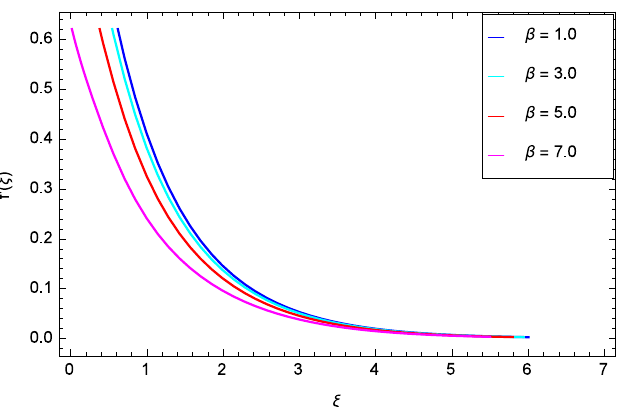
Figure 3. Impact of the ferrohydrodynamic interaction parameter β on velocity profile f (cid:48) ( ζ ) .